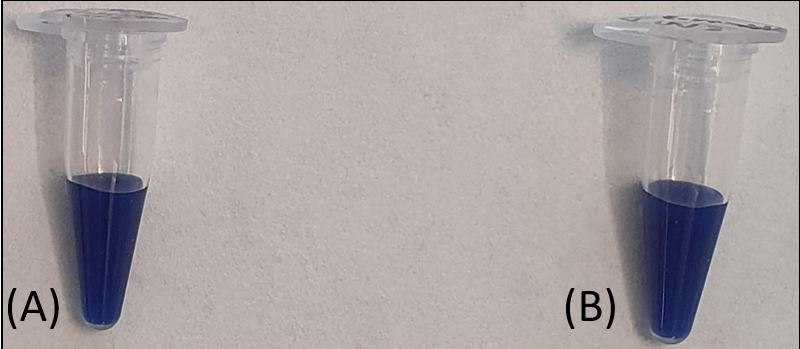
Figure 2. Suspensions of PCDA vesicles with ( A ) 0.01% HA epitope or ( B ) 0.01% scrambled HA epitope after 3 min of UV irradiation at 254 nm.